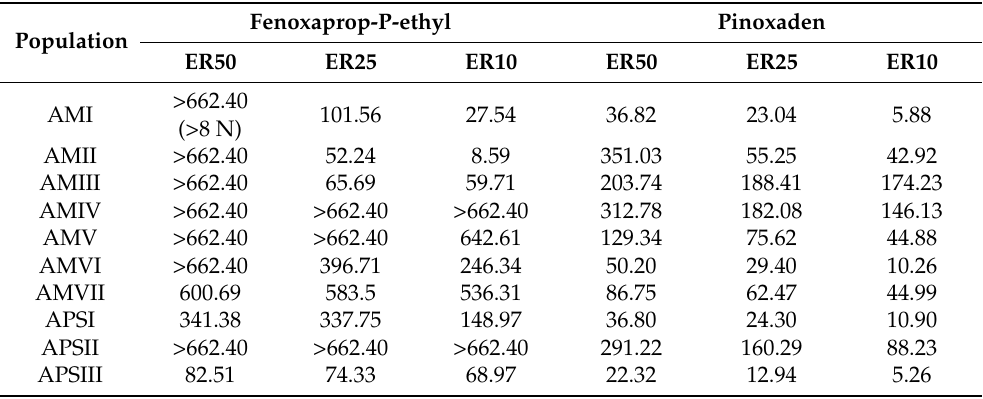
Table 1. ERx (g a.s. ha − 1 ) values for A. myosuroides (AMI–AMVII) and A. spica-venti (APSI–APSIII) populations treated with fenoxaprop-P-ethyl and